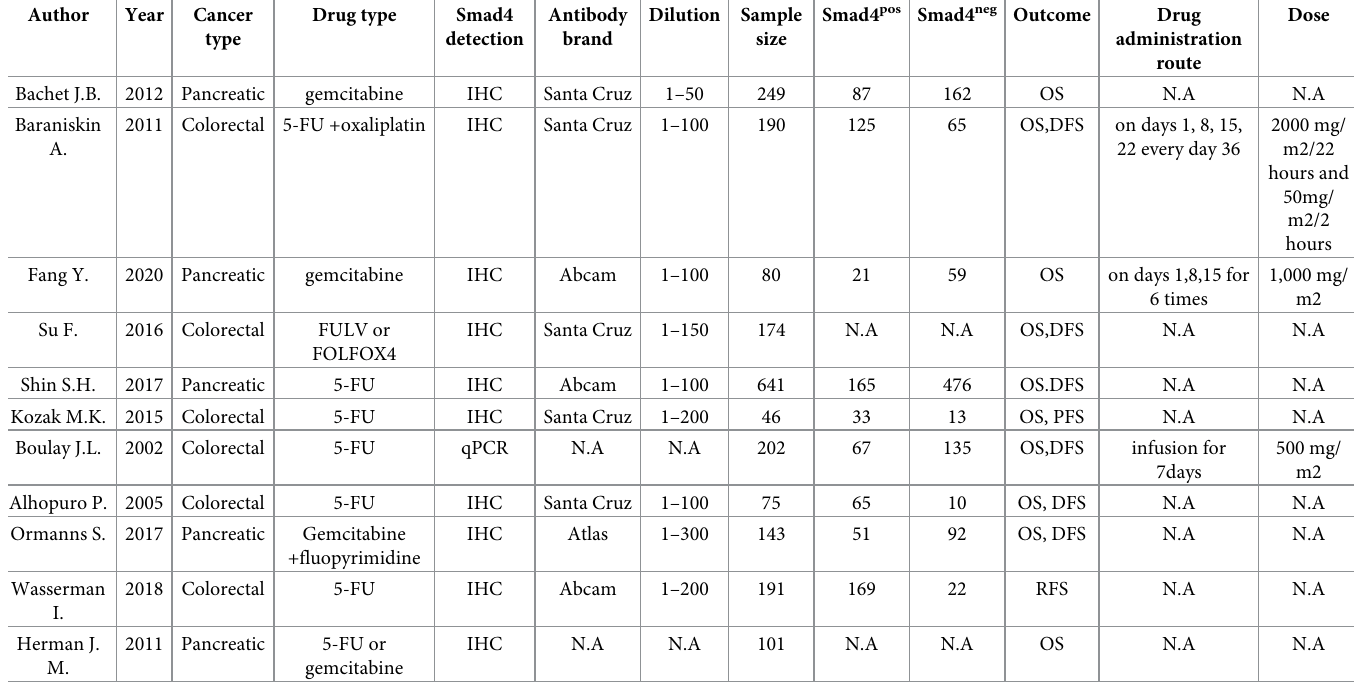
Table 1. Main characteristics of included